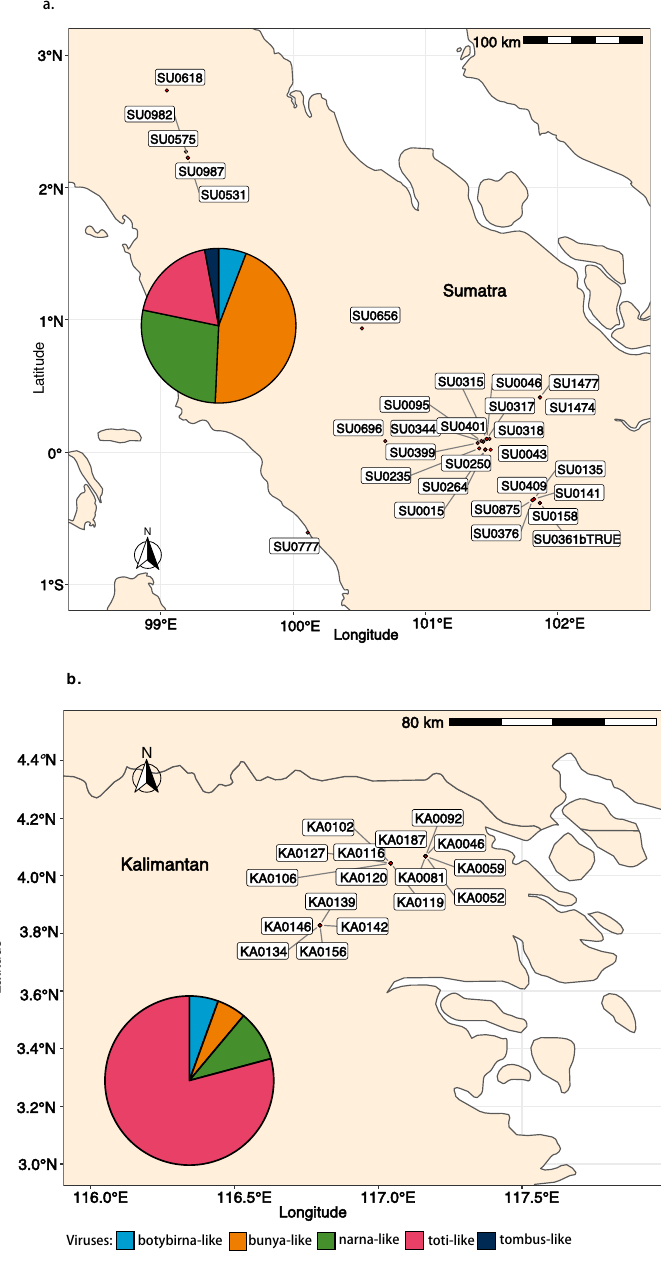
Figure 7. ( a ). Map showing the sites of the virus-hosting “ P. palustris ” isolates in Sumatra. ( b ). Map Figure 7. ( a ) . Map showing the sites of the virus-hosting ” P.palustris” isolates in Sumatra. ( b ). Map showing the sites of the virus-hosting ” P. palustris ” isolates in Kalimantan. The pie charts illustrate showing the sites of the virus-hosting “ P. palustris ” isolates in Kalimantan. The pie charts illustrate the relative frequency of each virus family/order in Sumatra and Kalimantan. the relative frequency of each virus family/order in Sumatra and